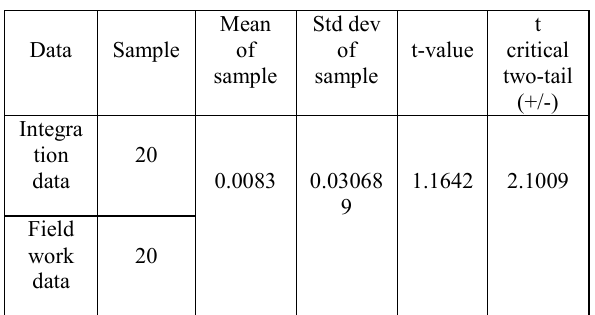
Table 2. The data needed for hypothesis